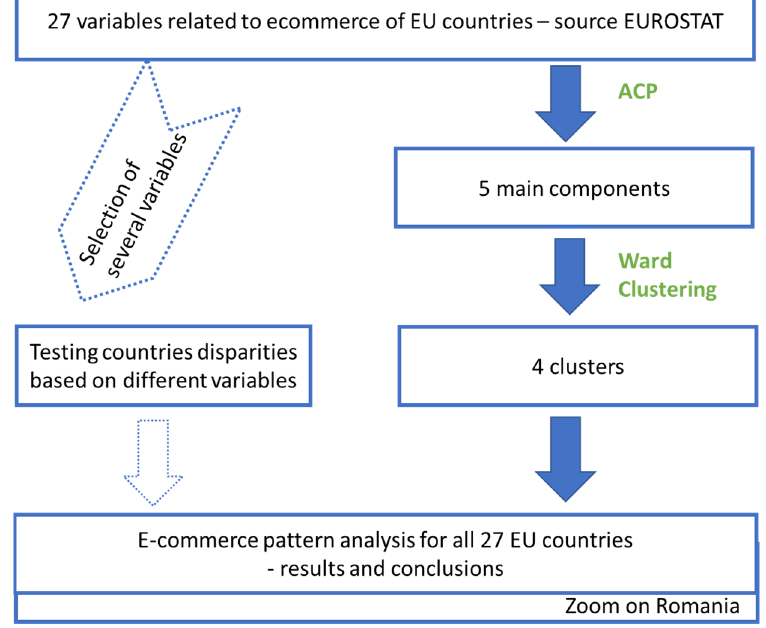
Figure 3. The conceptual research model.